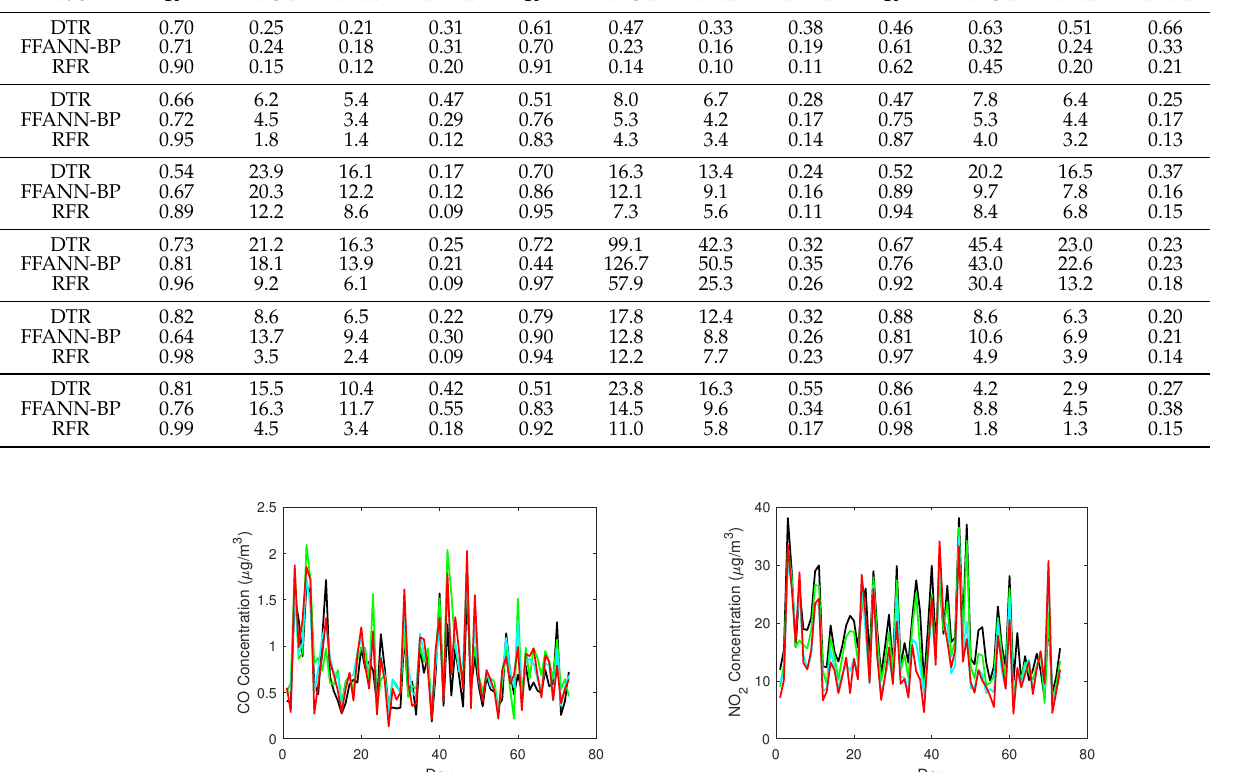
Table 6. The predicted performance of the DTR, FFANN-BP and RFR model for the concentrations of six air pollutants at Ma Lian Kou, Sha Po Tou and Ma Yuan in 2016. Sha Po Tou Ma Yuan